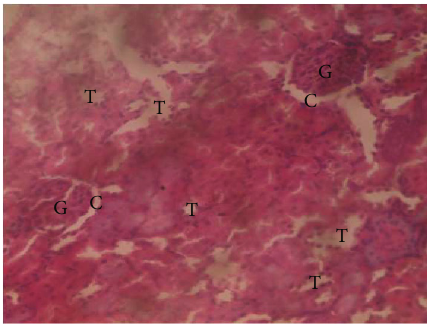
Figure 9: Photomicrographs of the group III rats with normal kidney of glomeruli containing mesangial cells, mesangial matrix, and capillaries, patent Bowman ’ s capsule spaces, and intact renal tubules.